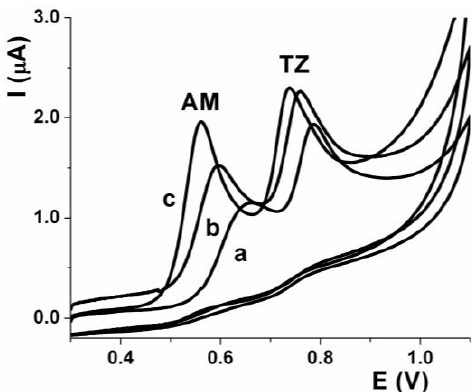
Figure 2. CV of AM and TZ (17.7 µmol L –1 ) solutions at pH 3.2; adjusted with nitric acid (curve a), acetate buffer (curve b), and phosphate buffer (curve c). Scan rate 50 V s −1 .